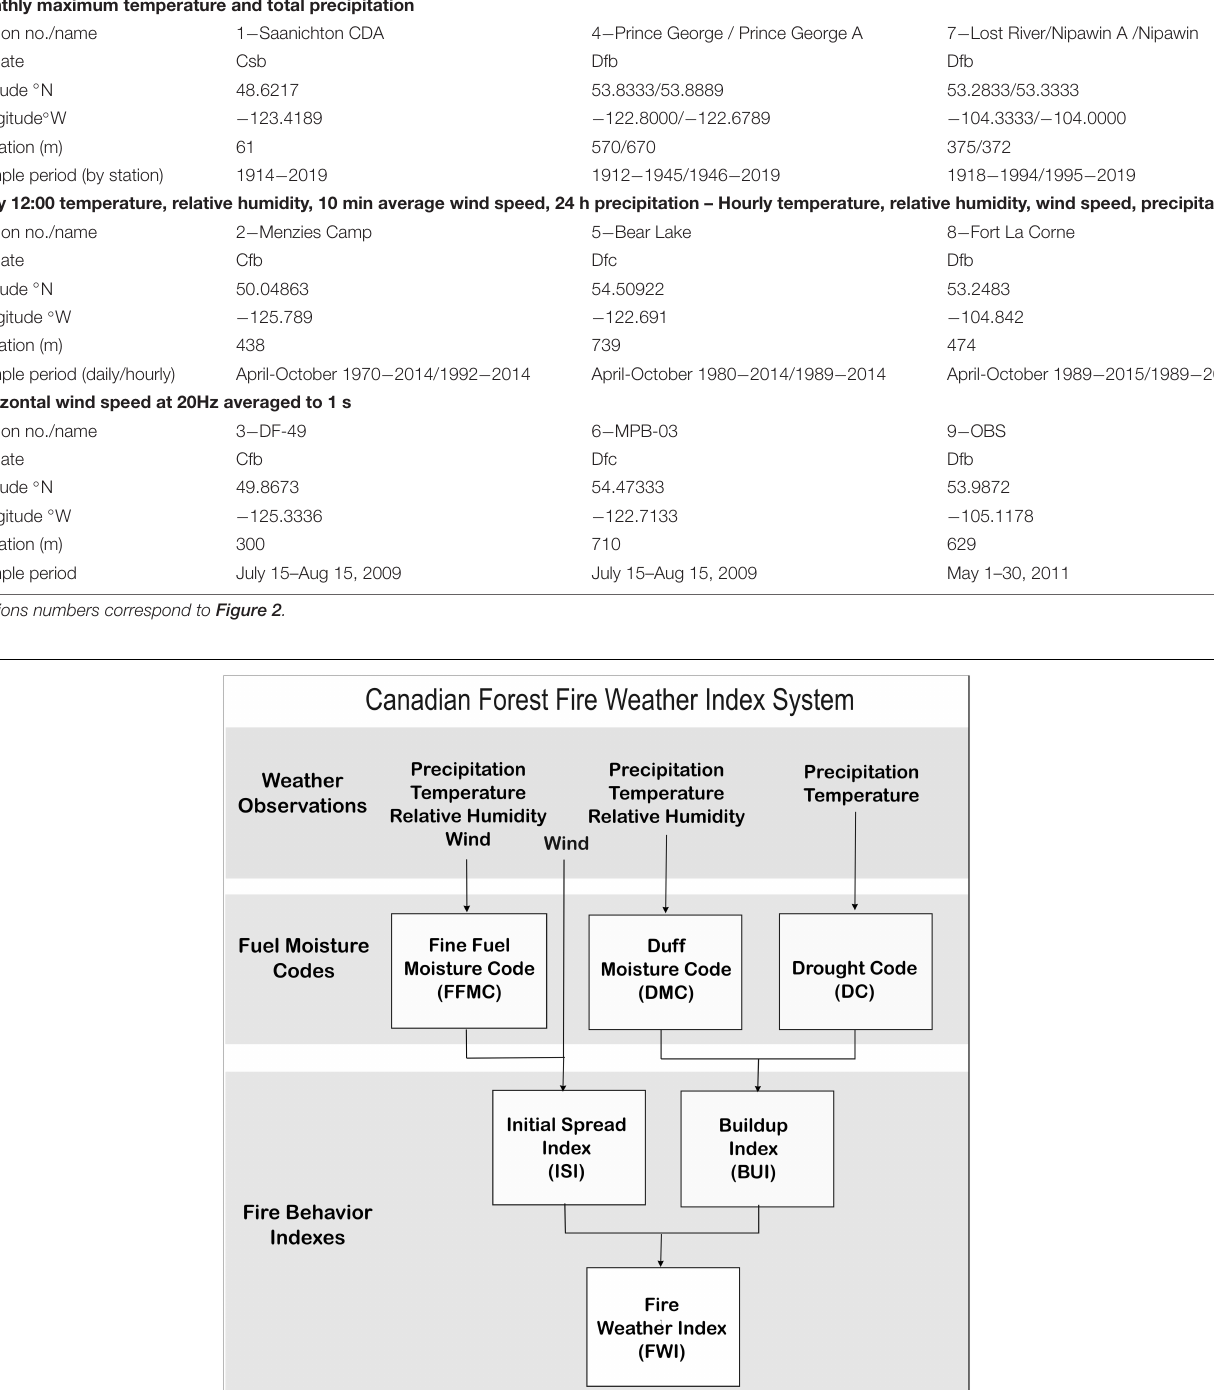
Frontiers in Environmental Science |